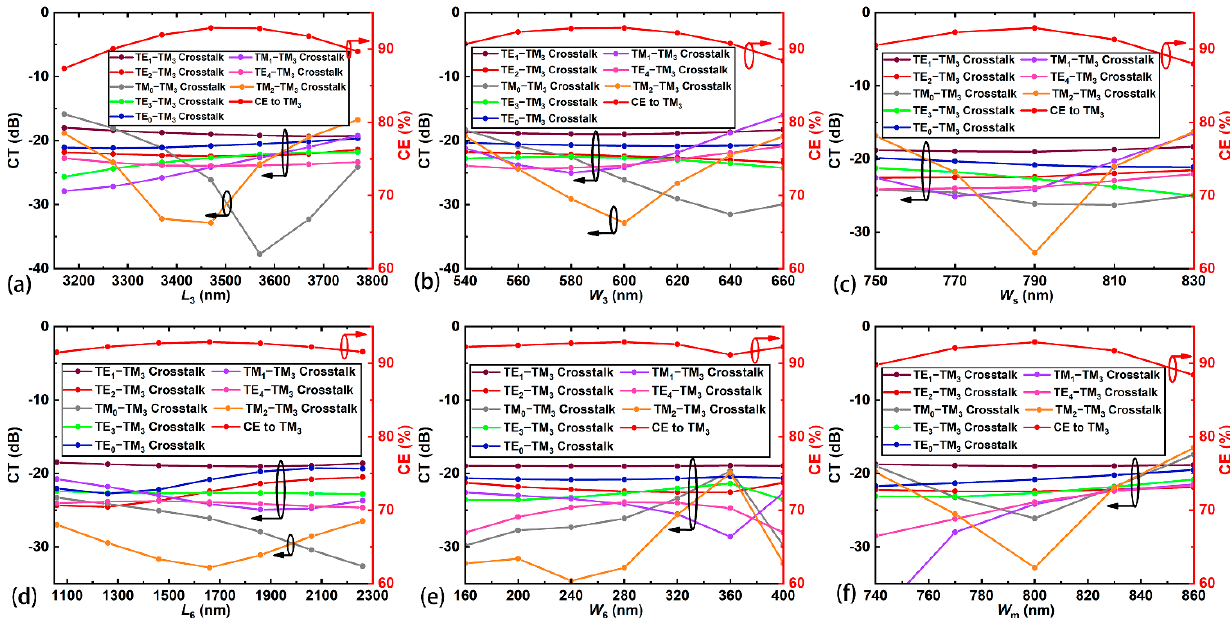
Figure 3. Mode CE and CT of the proposed TM 0 -to-TM 3 mode-order converter as functions of ( a ) length L 3 , ( b ) width W 3 , ( c ) relative distance W s of slot 3, and ( d ) length L 6 , ( e ) width W 6 , ( f ) relative distance W m of slot 6, respectively.